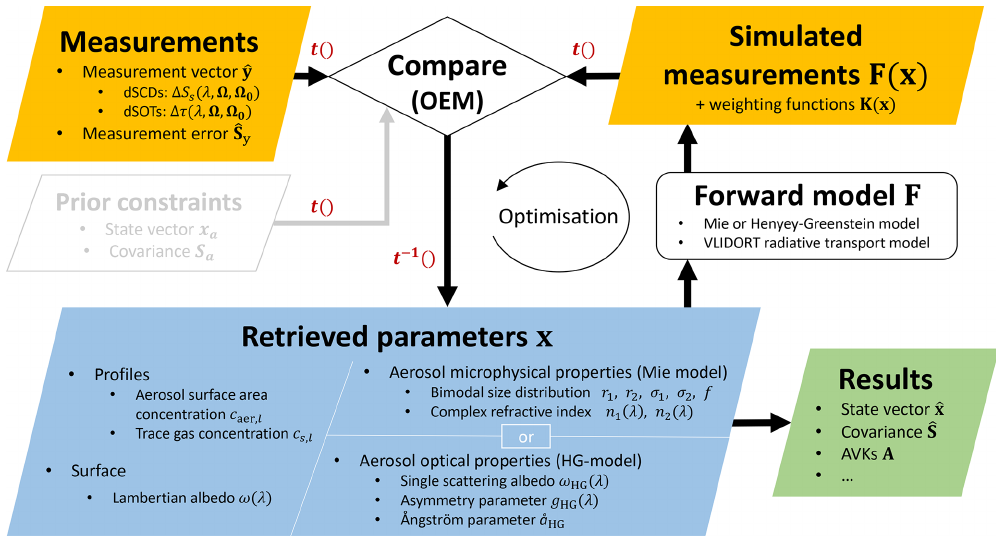
Figure 1. Schematic overview of the RAPSODI retrieval algorithm. The individual components are discussed in detail in the following subsections. Red labels next to arrows indicate transformations to/from optimised units, as described in Sect.